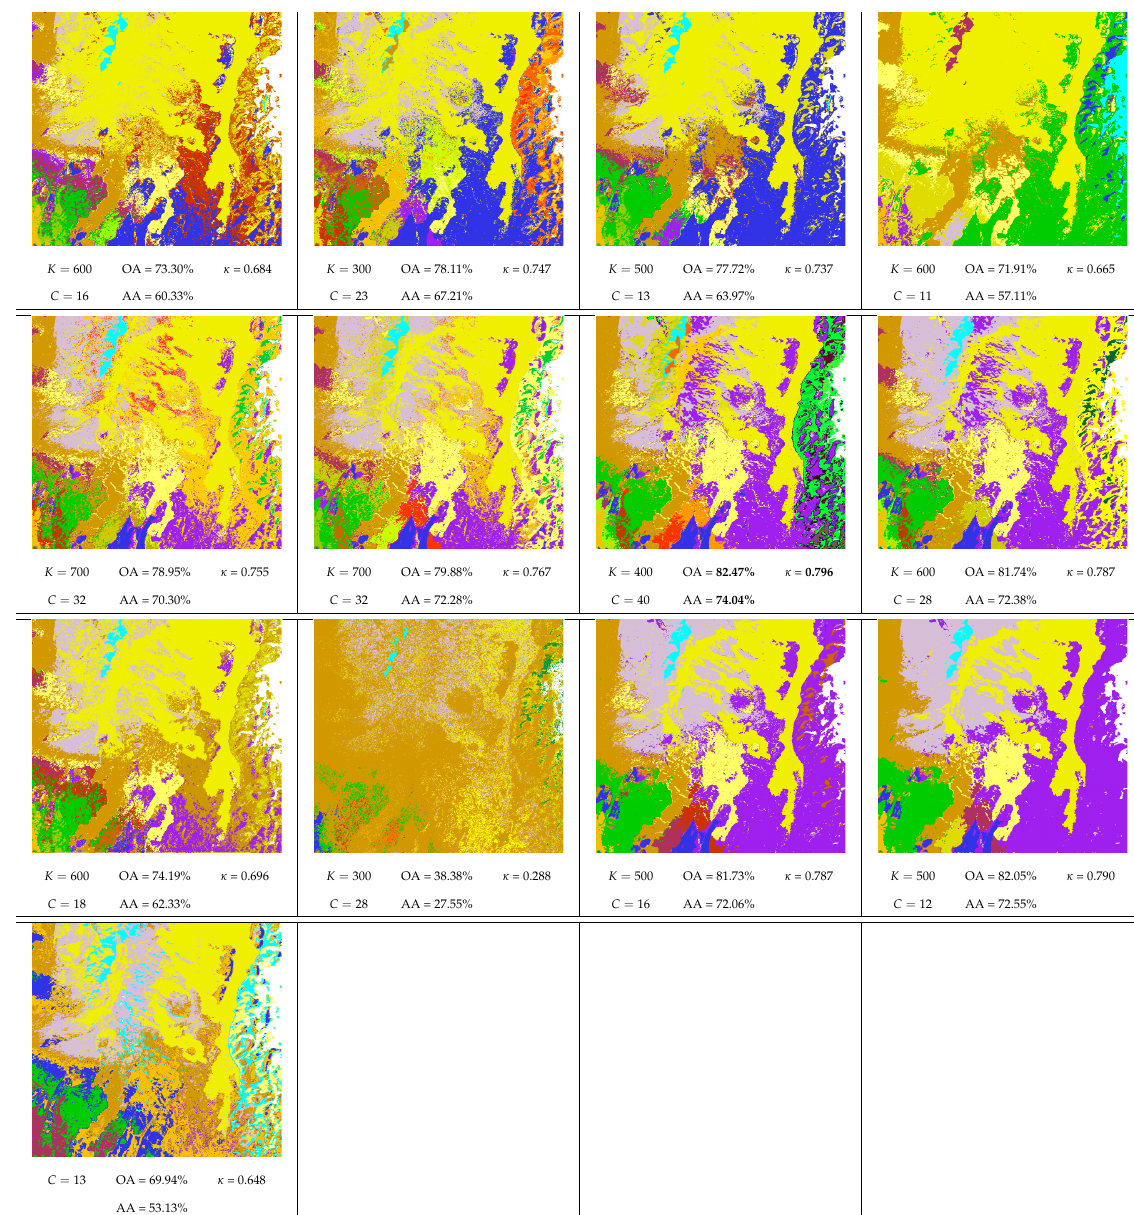
Figure 12. Best clustering maps with regard to kappa index for Hekla HSI with FCM and proposed methods. First row: baseline methods; second row: with MNN; third row: with MNN and spatial context; from first to fourth column, respectively: MODESEEK , M - KNN - DPC , GWENN - WM , M - KNNCLUST - WM . Fourth row: FCM